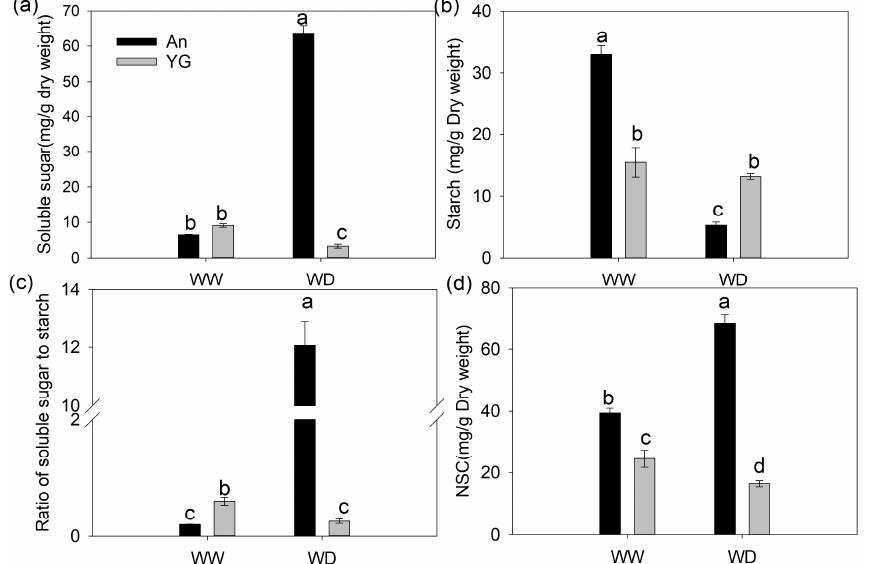
Figure 3. Non-structural carbon in the root system at the flowering state of the two cultivars: ( a ) soluble sugar; ( b ) starch; ( c ) soluble sugar to starch ratio; ( d ) non-structural carbohydrates. The different letters represent significant differences of WD, WW, An and YGl ( p < 0.05).